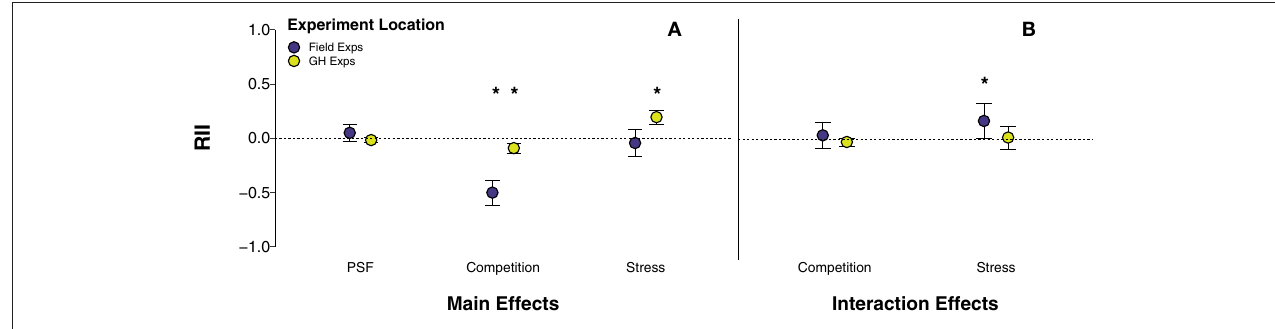
FIGURE 3 | (A) Main effects of PSF, competition, stress, and disturbance and (B) interaction effects of PSF x competition and PSF x stress between field and greenhouse experiments. Interaction effects of PSF x competition and PSF x stress are averaged across soil manipulations (live/sterile, away/home, untreated/fungicide) and across competition and stress manipulations. Error bars represent lower and upper bounds of the confidence intervals. Asterisks indicate effect sizes significantly different from